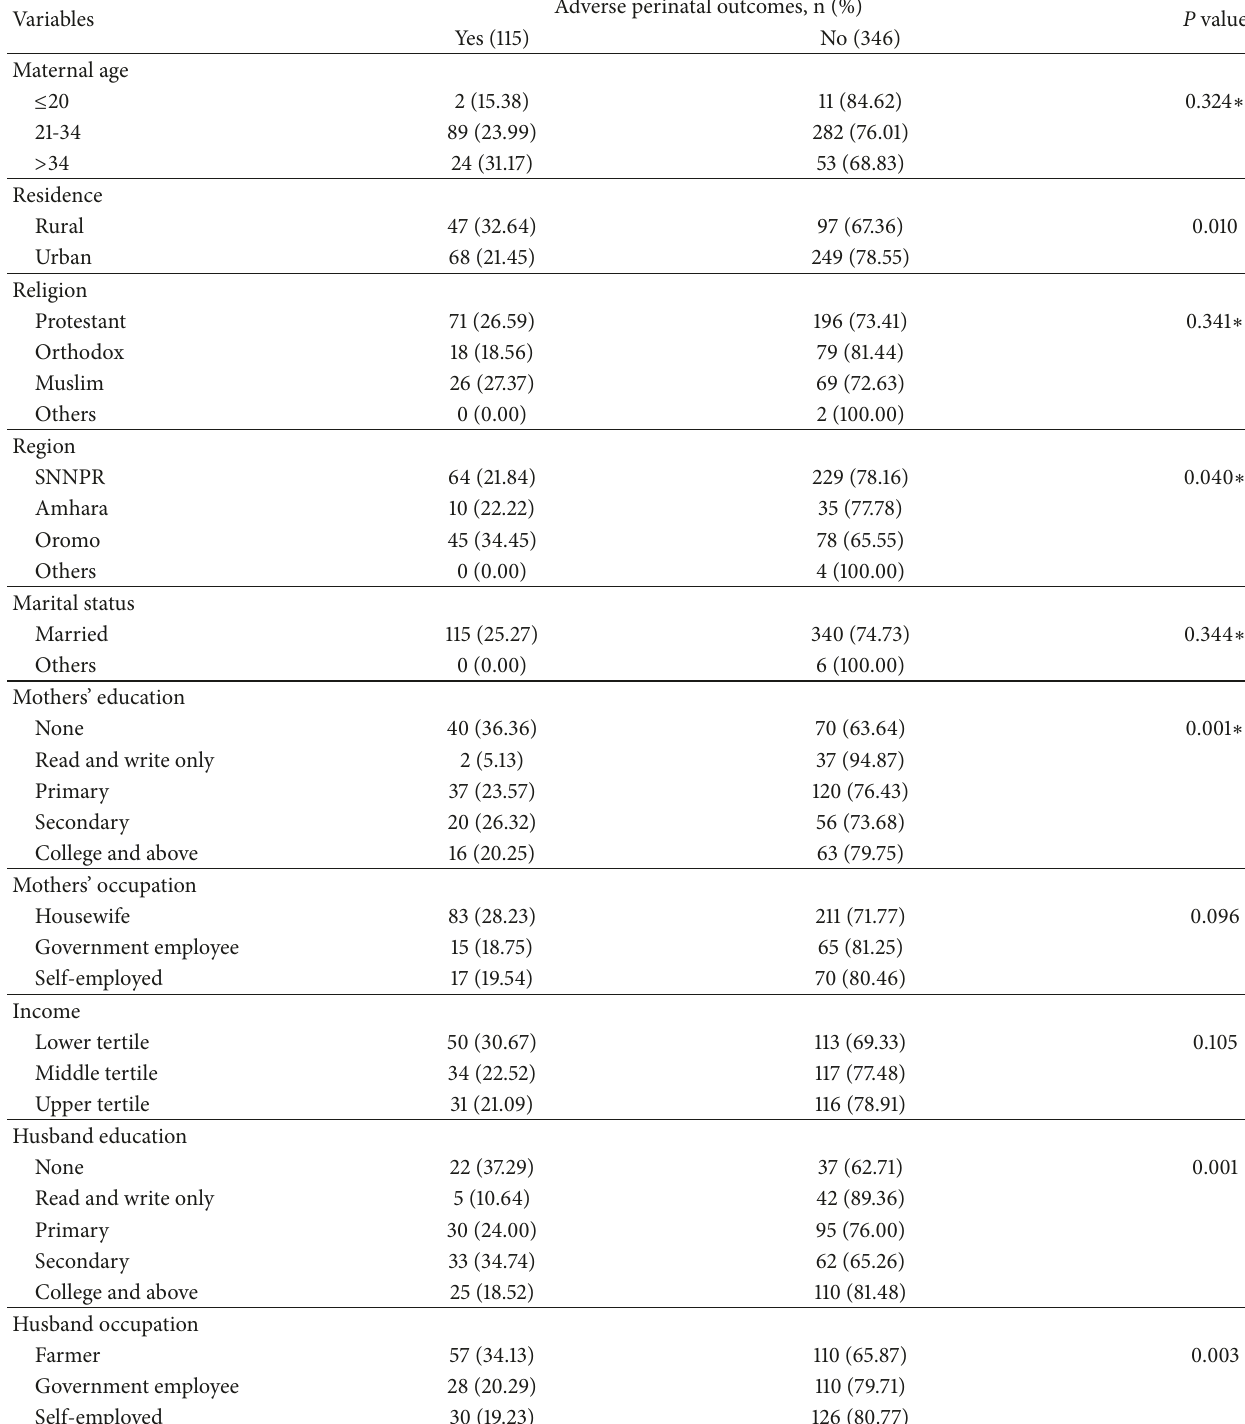
Table 1: Distribution of sociodemographic characteristics by perinatal outcomes in HUCSH & AGH, Southern Ethiopia, September 2018.